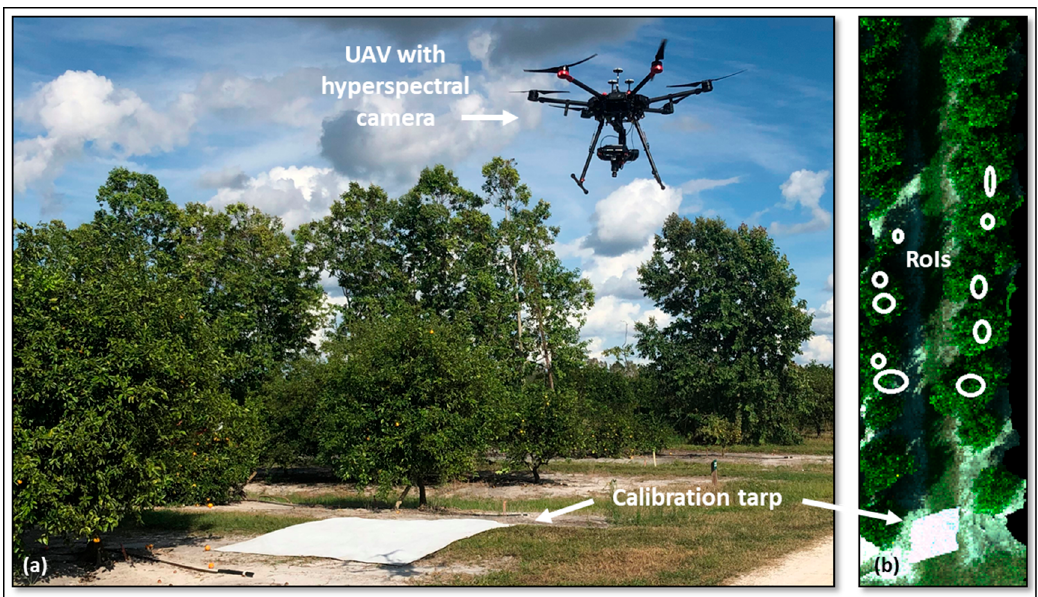
Figure 4. The unmanned aerial vehicle (UAV)-based data collection system that was used for regions of interest (RoI) collection from citrus canker-infected Sugar Belle tangerine trees in the orchard. ( a ) UAV-based data collection system; ( b ) random selection of twenty RoIs from citrus trees infected with citrus canker.